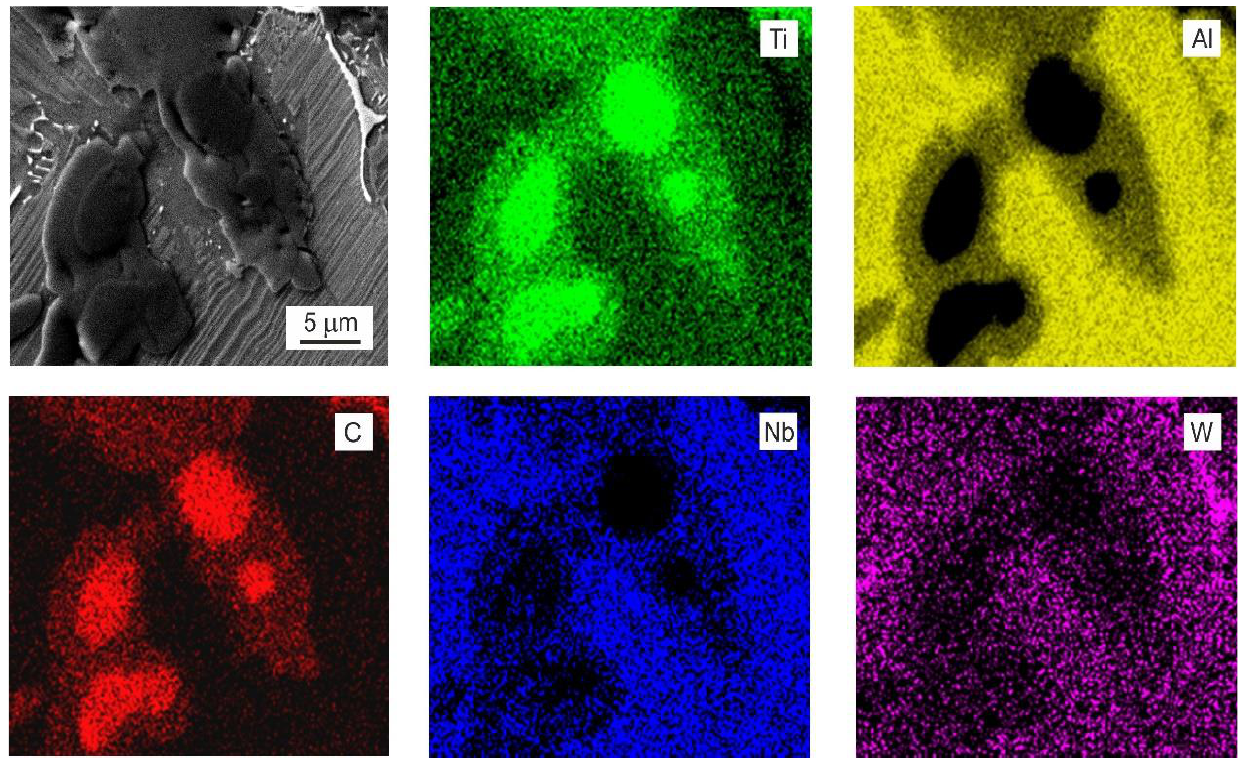
Figure 5. SEM micrograph and corresponding EDS map analysis of the tilt-cast NbW alloy. The results of the statistical evaluation of quantitative image analysis data of carbide particles, such as mean length of major axis L maj , mean length minor axis L min , volume